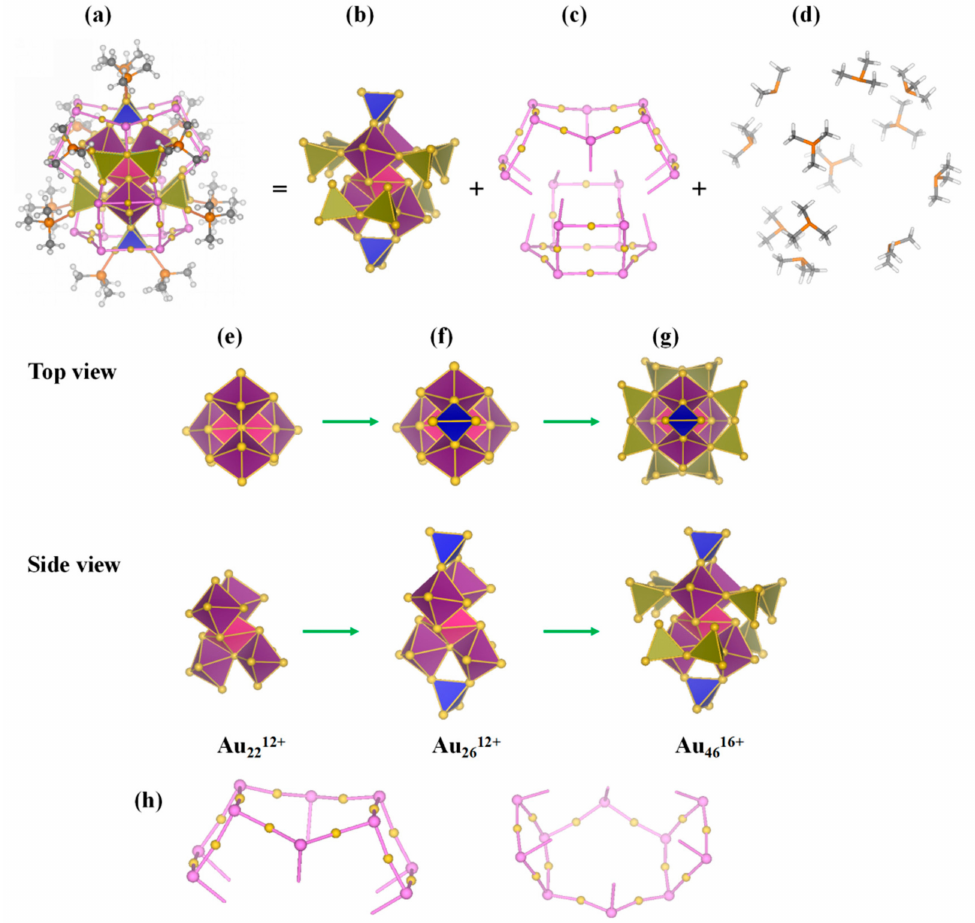
Figure 2. ( a ) Structural model of Au 70 S 20 (PCH 3 ) 12 . The [Au 12 ( µ 3 -S) 10 ] 8 − and PCH 3 protecting motifs are given as ball-and-stick models (Au, yellow; P, orange; S, pink; C, gray; H, white). The Au cores are shown as polyhedra. ( b ) Model of Au 4616 + core, ( c ) Two [Au 12 ( µ 3 -S) 10 ] 8 − six-tooth staple motifs, ( d ) Model of twelve PCH 3 protecting motif, ( e ) 6 × 2e SAN of Au 2212 + core, ( f ) Au 2612 + core, ( g ) Au 4616 + core, ( h ) Two views of [Au 12 ( µ 3 -S) 10 ] 8 − staple